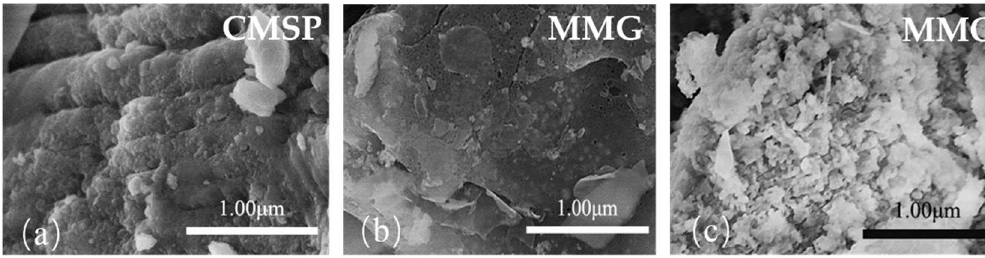
Figure 7. SEM images of CMSP ( a ); MMG ( b ); and MMO ( c ) at a magnification of 50,000 × .